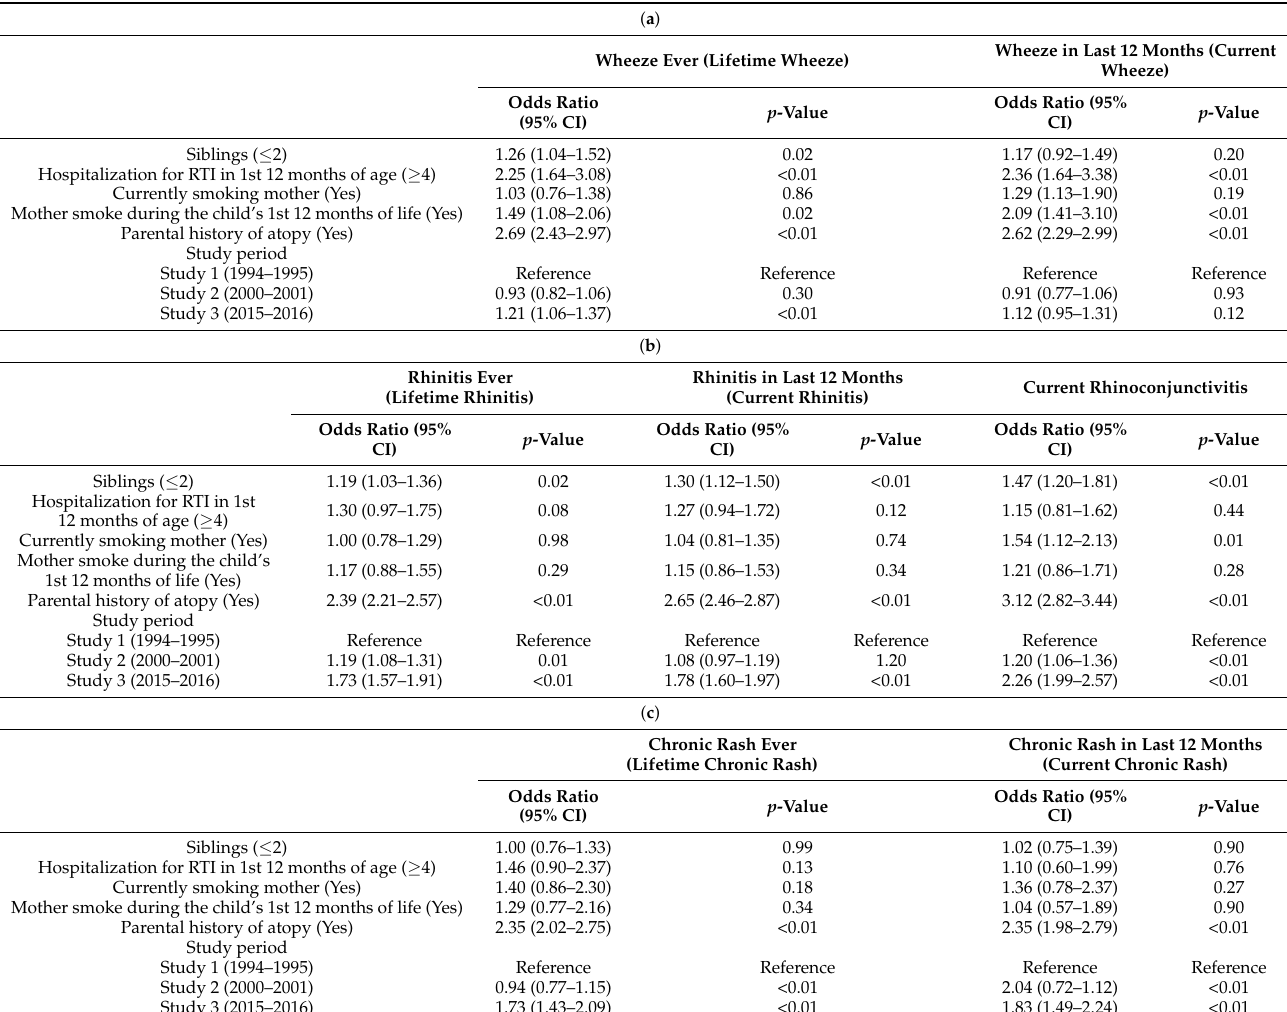
Table 3. ( a ) Multiple logistic regression to assess association between risk factors and prevalence change in lifetime wheeze and current wheeze. ( b ) Multiple logistic regression to assess association of risk factors with prevalence change in lifetime rhinitis, current rhinitis, and current rhinoconjunctivitis. ( c ) Multiple logistic regression to assess association of risk factors with prevalence change in lifetime chronic rash and current chronic